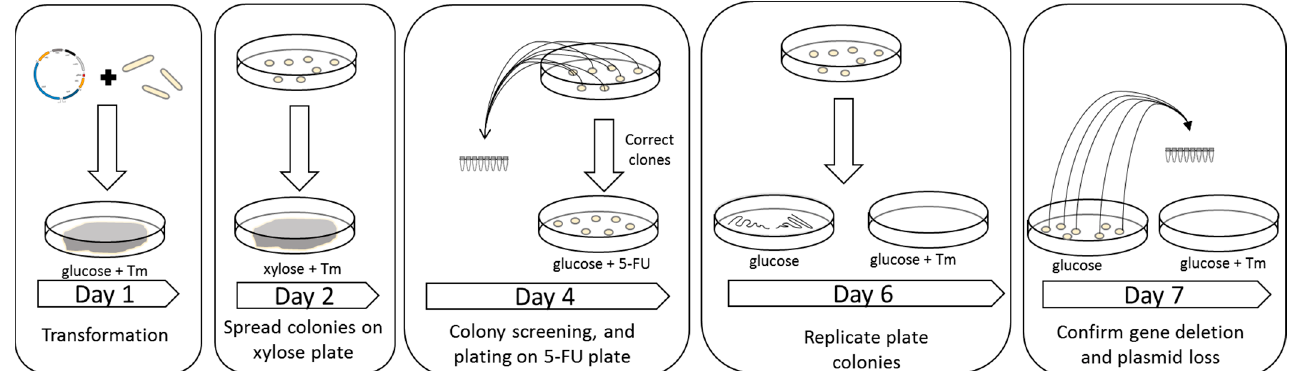
Figure 3. Schematic diagram of the procedure of performing genetic modifications using the CRISPR/Cas9 system in C. acetobutylicum . Day 1: Transformation of the strain CAS2 with a plasmid containing gRNA and homology arms. Day 2: Transformants were grown to an optical density (OD)1.0 in CGM containing glucose and then spread on a CGM plate containing xylose and relevant antibiotic. Day 4: Colonies were screened by PCR, grown until OD 1.0 in CGM containing glucose, and then spread on plates containing 5-fluorouracil (5-FU). Day 6: Colonies on 5-FU were replicated plated on plates with and without antibiotic. Day 7: Antibiotic sensitive colonies were then screened to confirm the correct genotype. The strain was then ready to be characterized and/or ready for another round of genetic modification.